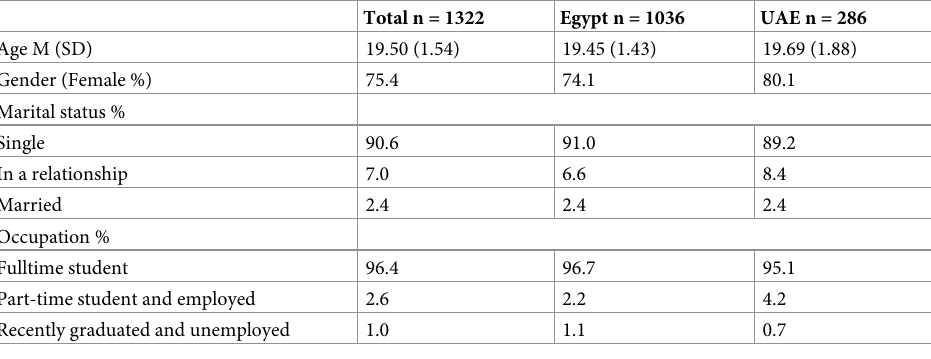
Table 1. Descriptive statistics for demographic variables (total sample and for each